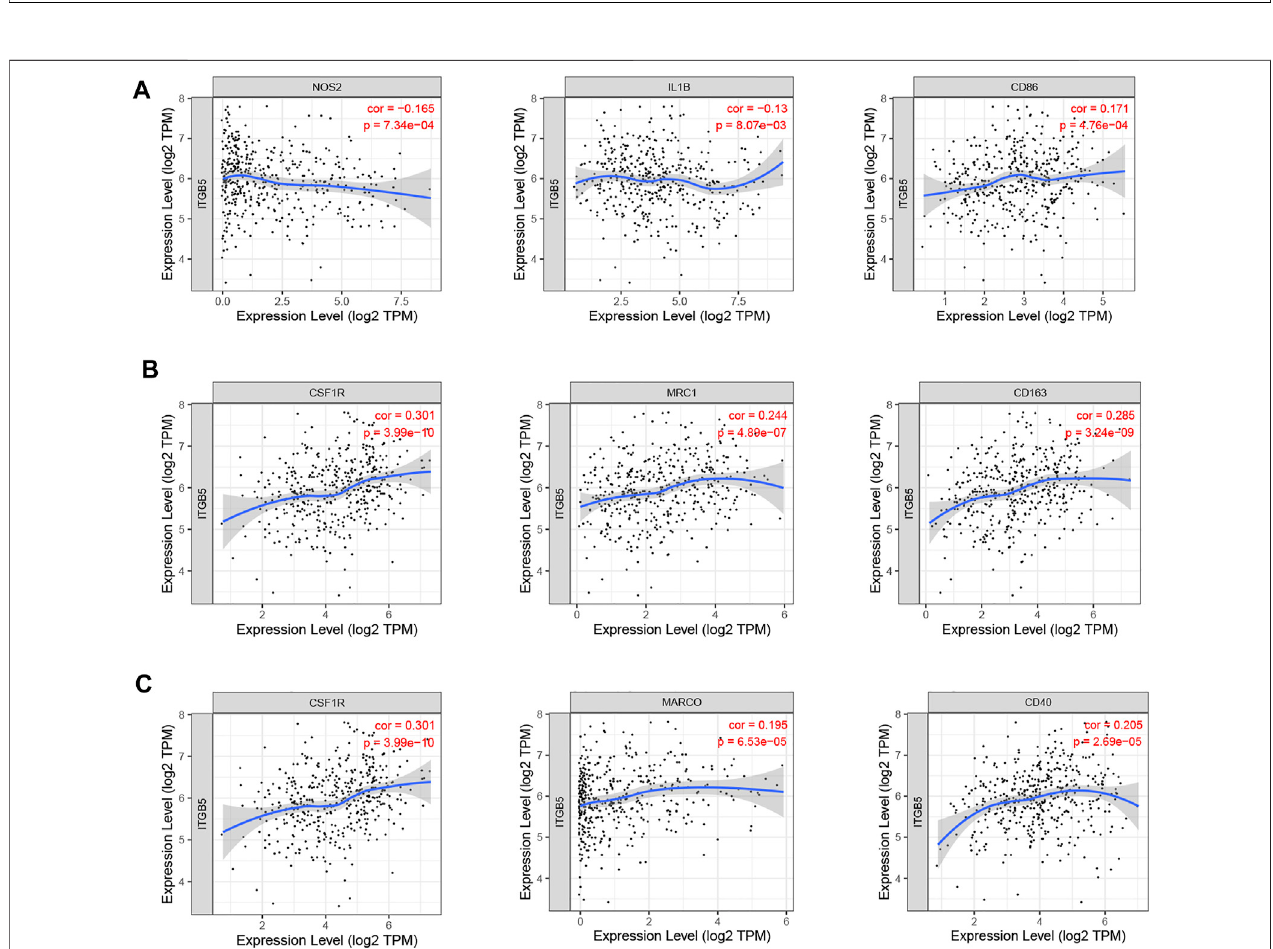
FIGURE13| CorrelationbetweenITGB5expression andgenemarkersofmacrophageinGC. (A) ITGB5 andM1macrophages. (B) ITGB5and M2macrophages. (C) ITGB5 and tumor-associated macrophages.